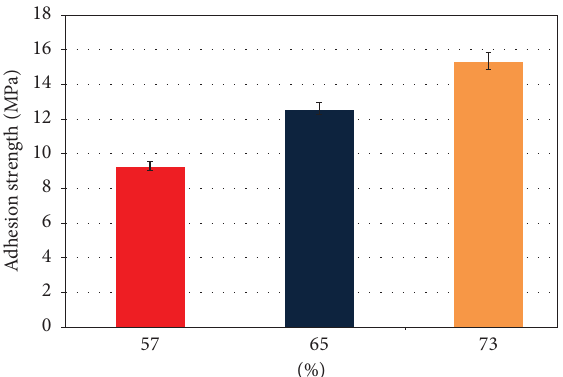
Figure 3: Graph of the adhesion strength of the Cr material at diferent barrel flls: ( a ) 57%; (b) 65%; and (c)